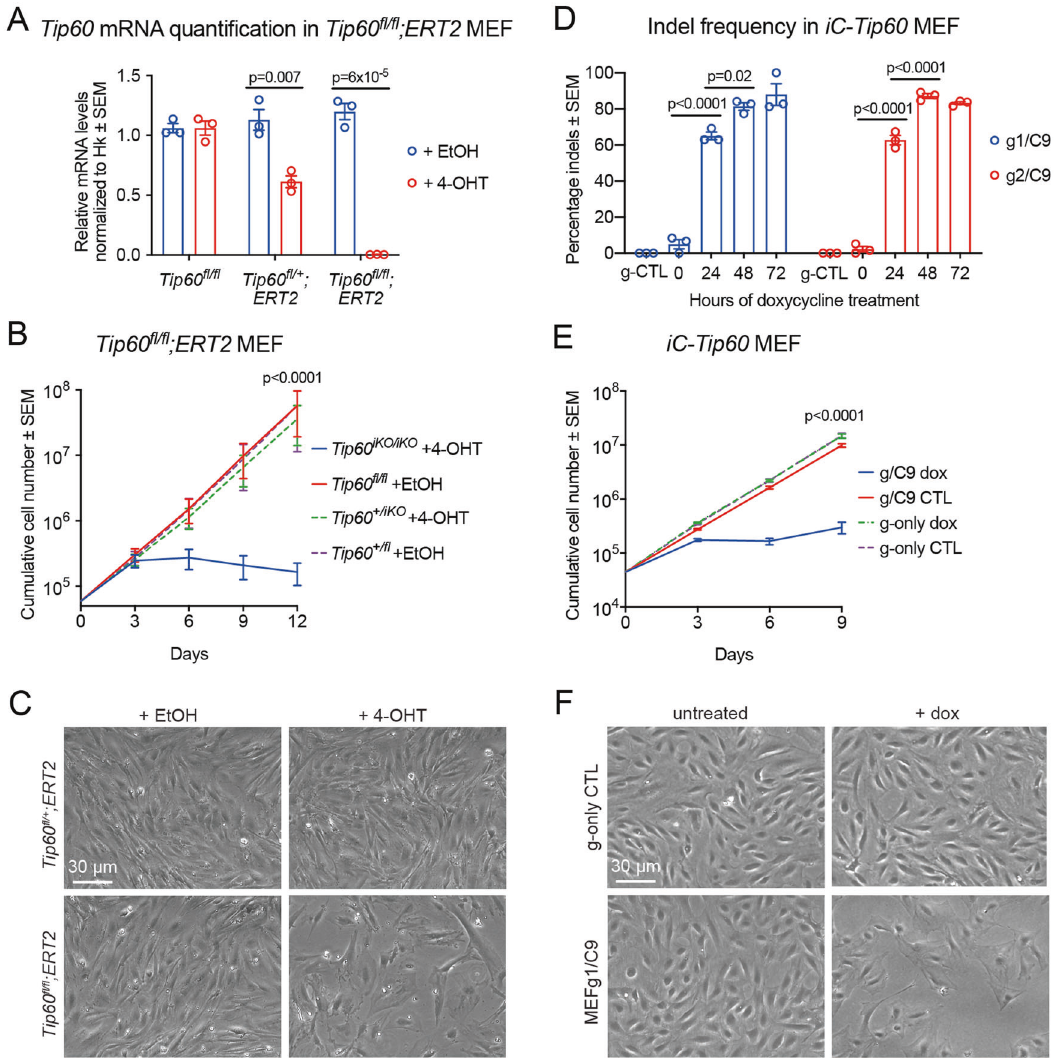
normal growth medium (means± SEM, n = 3, unpaired two-tailed t test on slopes of log-transformed values). C Representative phase-contrast images of Tip60 fl / fl ;ERT2 MEFs 5 days after 4-OHT induction vs. heterozygous and EtOH controls. D Quanti fi cation of indel frequencies